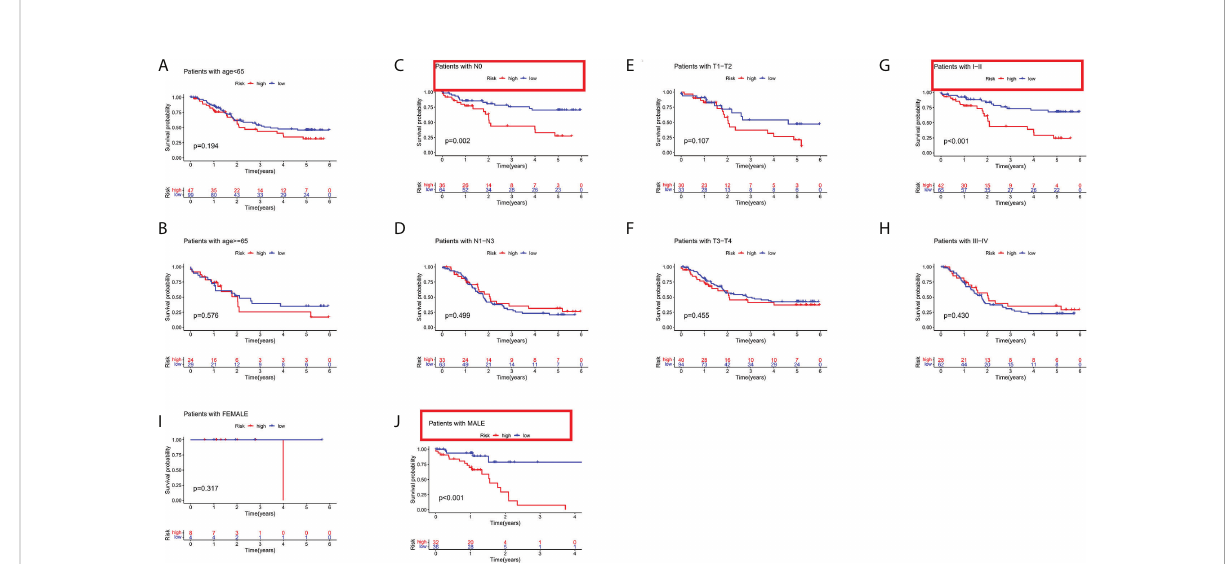
FIGURE 5 Subgroup analysis based on different clinical characteristics of the risk strati fi cation system. (A) age ≤ 65, (B) age > 65, (C) NO, (D) N1-N3, (E) T1- T2, (F) T3-T4, (G) stage I-II, (H) stage III-IV, (I) female, and (J)